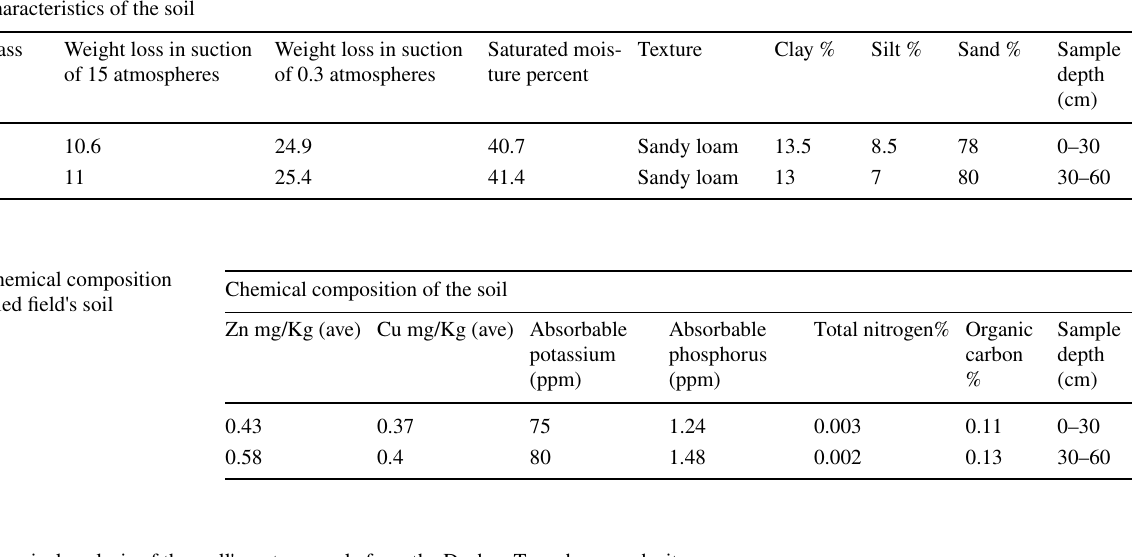
Table 1 Physical characteristics of the studied field's soil Physical characteristics of the soil Specific mass Weight loss in suction (g/cm 3 ) of 15 atmospheres